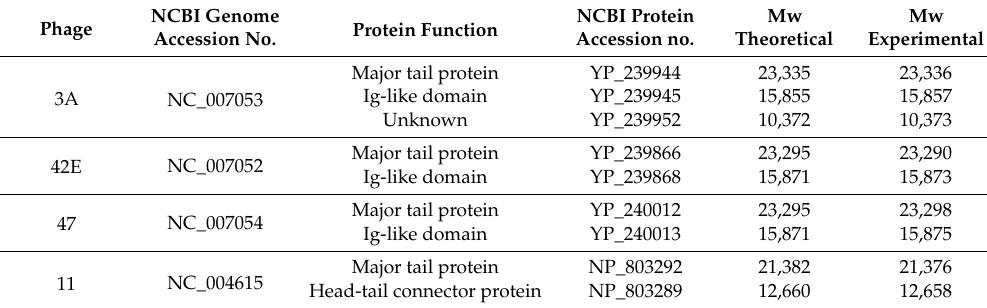
Table 3. List of proteins identified in MALDI-TOF MS